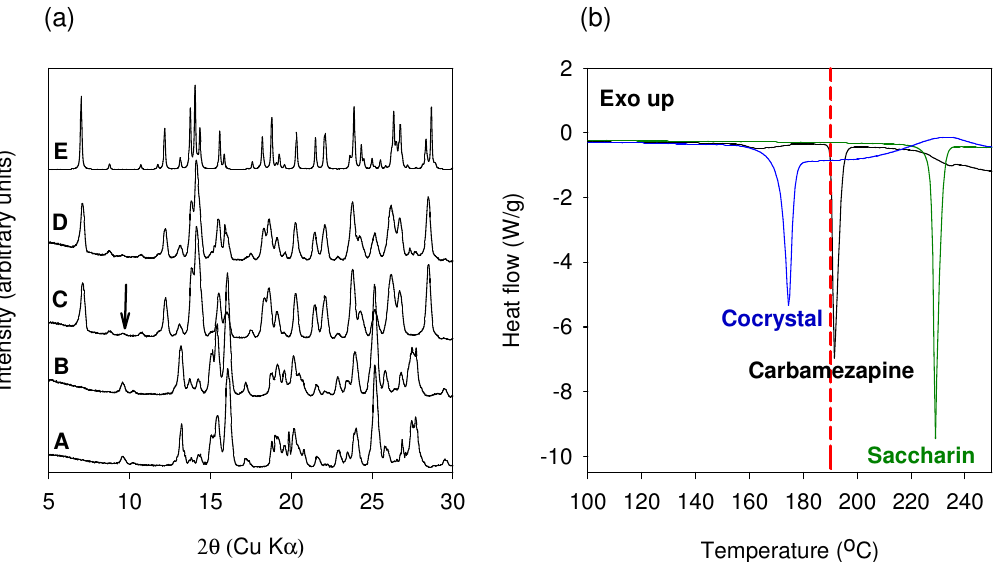
Figure 9. ( a ) XRPD of materials obtained from the TSE of Carbamazepine and Saccharin: A: Physical blend prior to extrusion, B: extrusion at 50 °C, C: Extrusion at 190 °C, D: Extrusion with water at 100 °C, E: Reference Form I cocrystal pattern calculated from the published crystal structure obtained from the Cambridge Structural Database (CSD). ( b